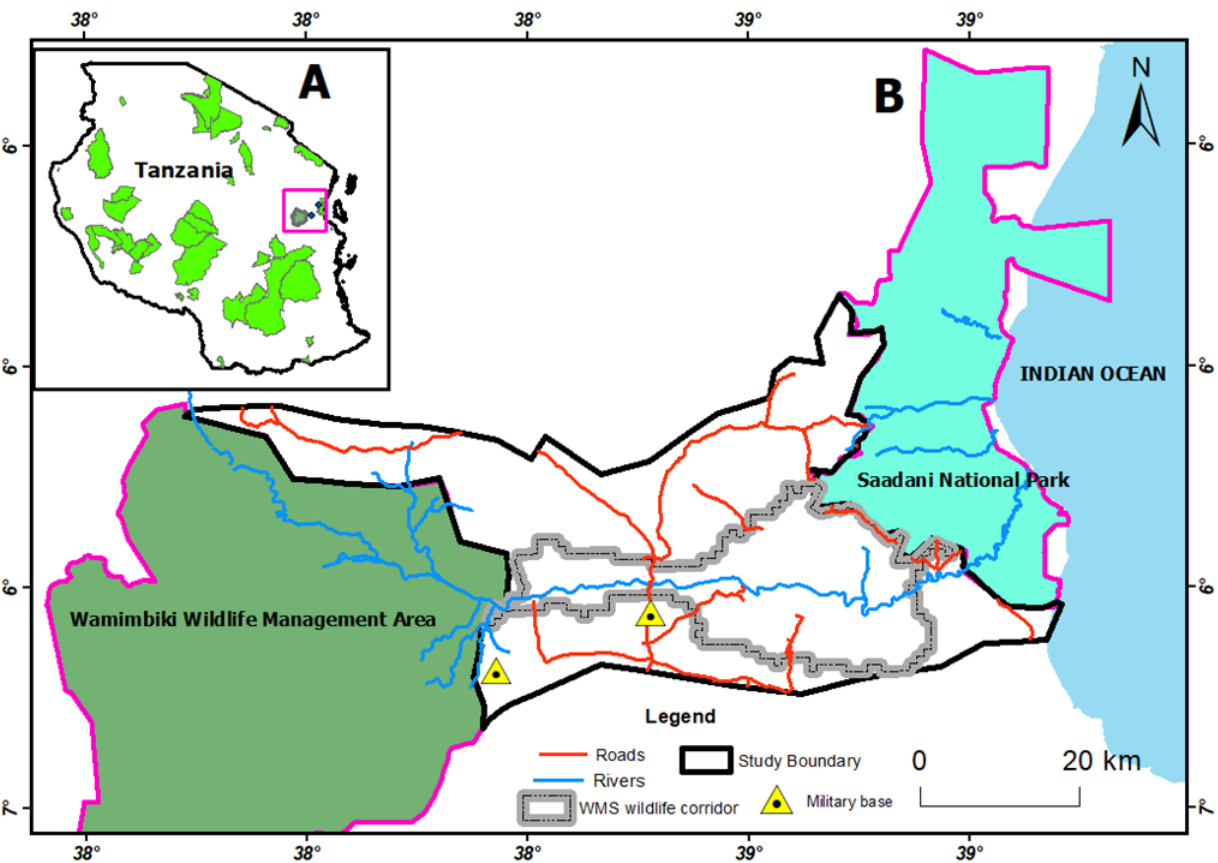
Figure 1. Map of the study area surveyed in Tanzania from 1998 to 2018 ( B ), the green patches in the small map ( A ) (map of Tanzania) show the protected areas in Tanzania, in general, in national parks and game reserves. The purple line is the protective areas boundary.